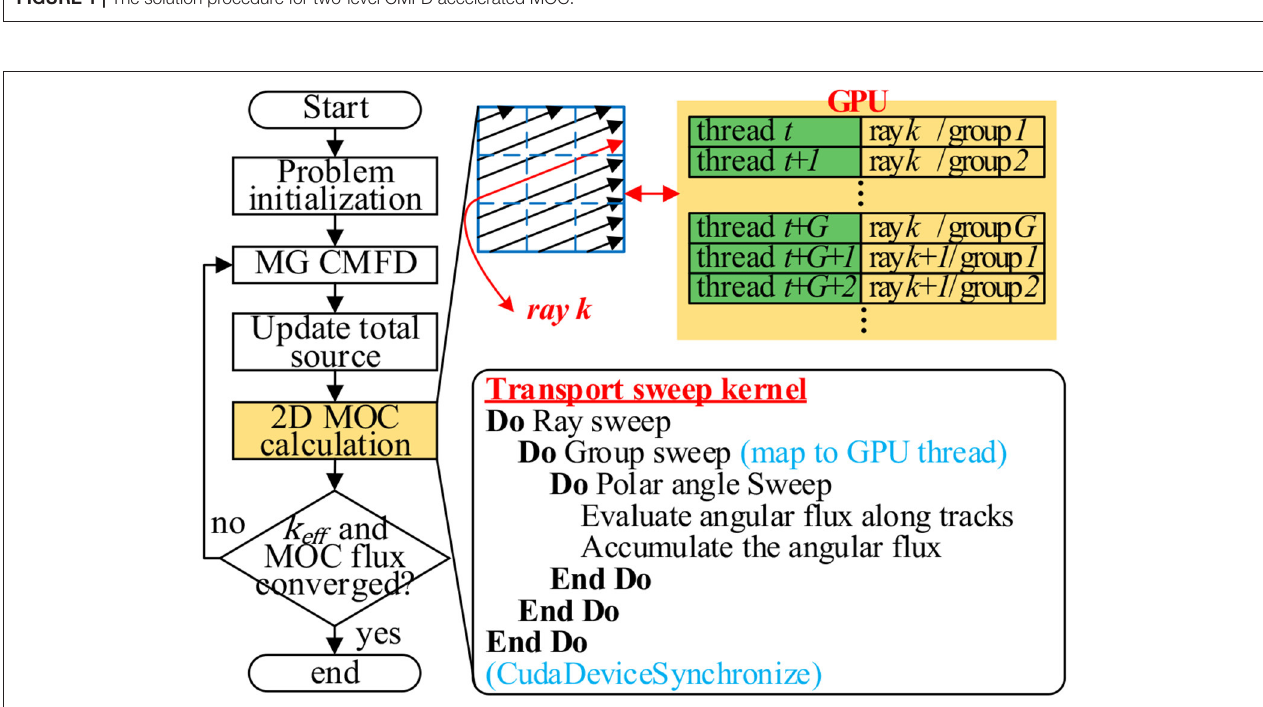
FIGURE 2 | Flowchart of the MOC neutron transport calculation on